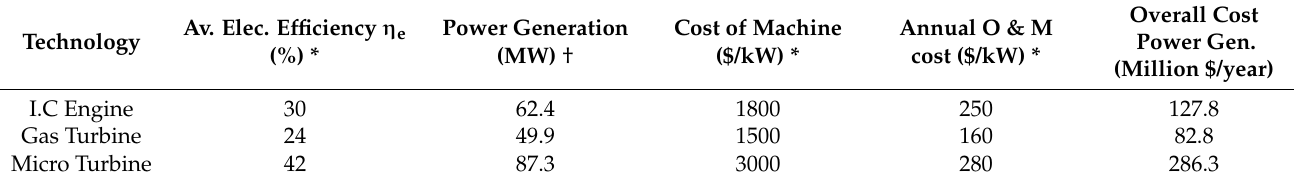
Table 11. Evaluation of power generation cost in present situation by using different technologies * [84], [† Table 10].